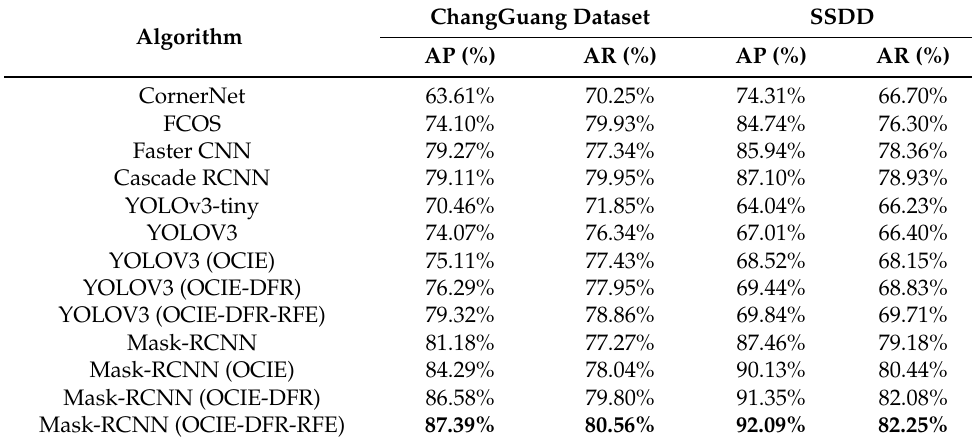
Table 4. Experimental results of the overall detection framework on the ChangGuang dataset and